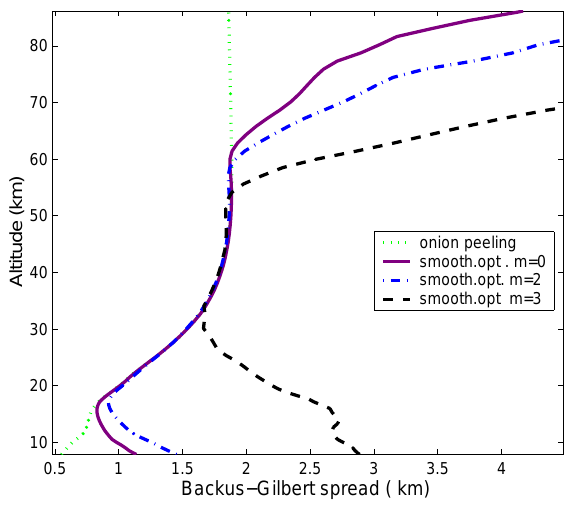
Fig. 8. Resolution obtained with MAP method with smoothness a priori for various magnitudes of star. The effective temperature is taken T =